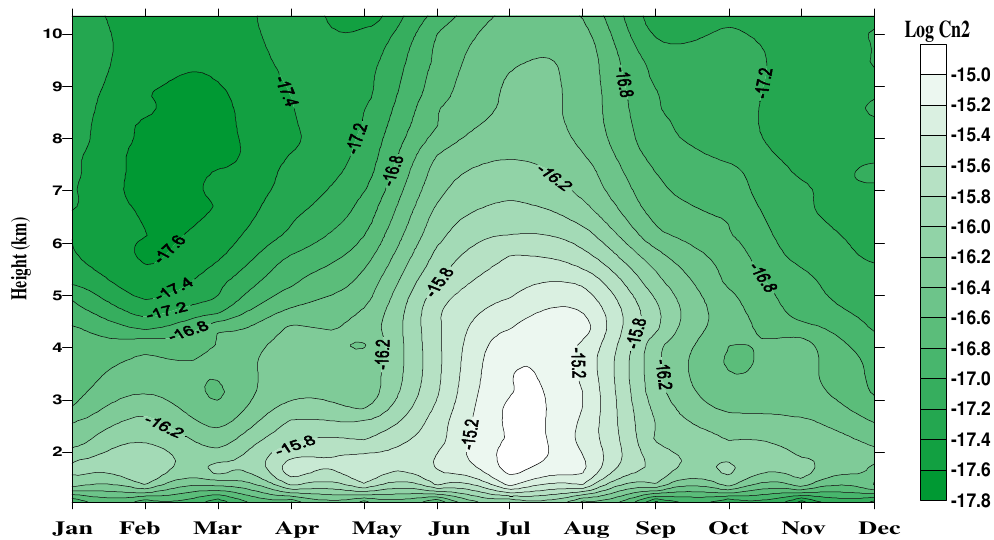
Fig. 8. Contour map for annual features of average Log C 2 n during 2003–2006. The monthly mean is calculated on daily averaged values 03:00, 06:00, 09:00 and 12:00GMT at all altitudes between 1 and